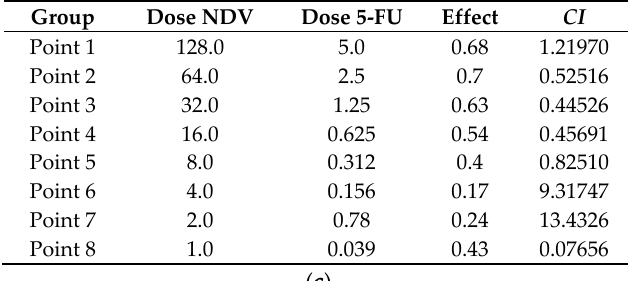
Figure 2. Combination cytotoxicity on RD cells. ( a ) Cytotoxic effect of 5-FU, NDV, or both, on RD cell proliferation. The cells were treated with 5-FU (5 µg in two-fold serial dilutions reaching 0.039 µg/mL), NDV (128 HUA with two-fold serial dilutions), or a combination of the two. The results for the treated groups are expressed as the cell proliferation rate compared with untreated control cells grown under identical conditions; ( b ) isobologram analysis showing synergism between NDV and 5-FU at the most higher doses and antagonism at lower doses (while the points that are extremely antagonized will not show in the figure such as point 6 and 7 as their value above 2 and will not be able to be included) ; and ( c ) table summarizing the combination index data for each dose of combination points.